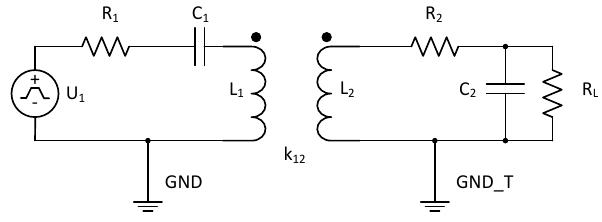
Figure 10. The oscillator circuits of the RFID reader and the transponder with connected sensor element described with the load resistance R L as well as L 1 and L 2 , which represent the transmitter and the transponder